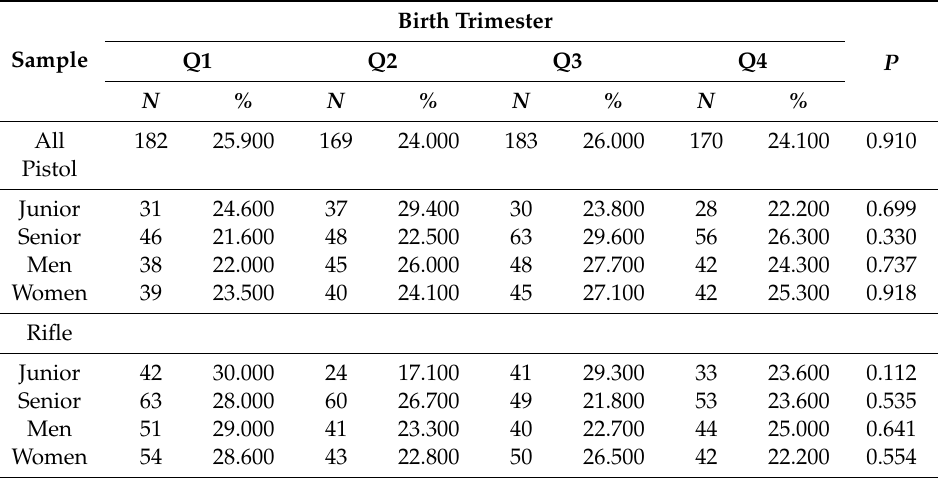
Table 4. Frequency or percentage of participants by birth